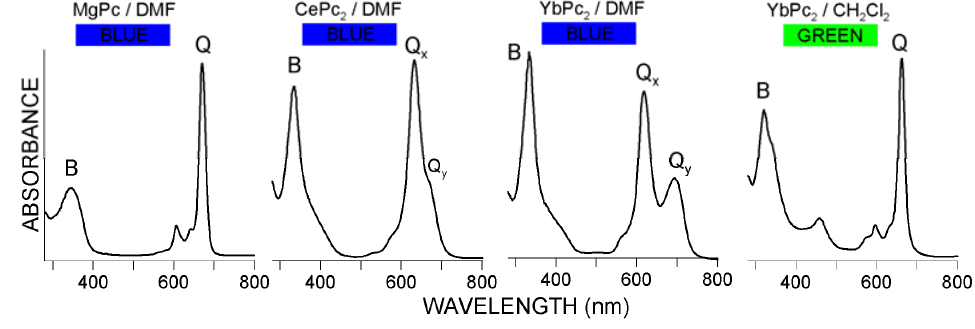
Figure 2. Electronic absorption spectra of diverse metallophthalocyanines in DMF and dichloromethane; note the differences in position and shape of the B and Q bands, as well as the solution